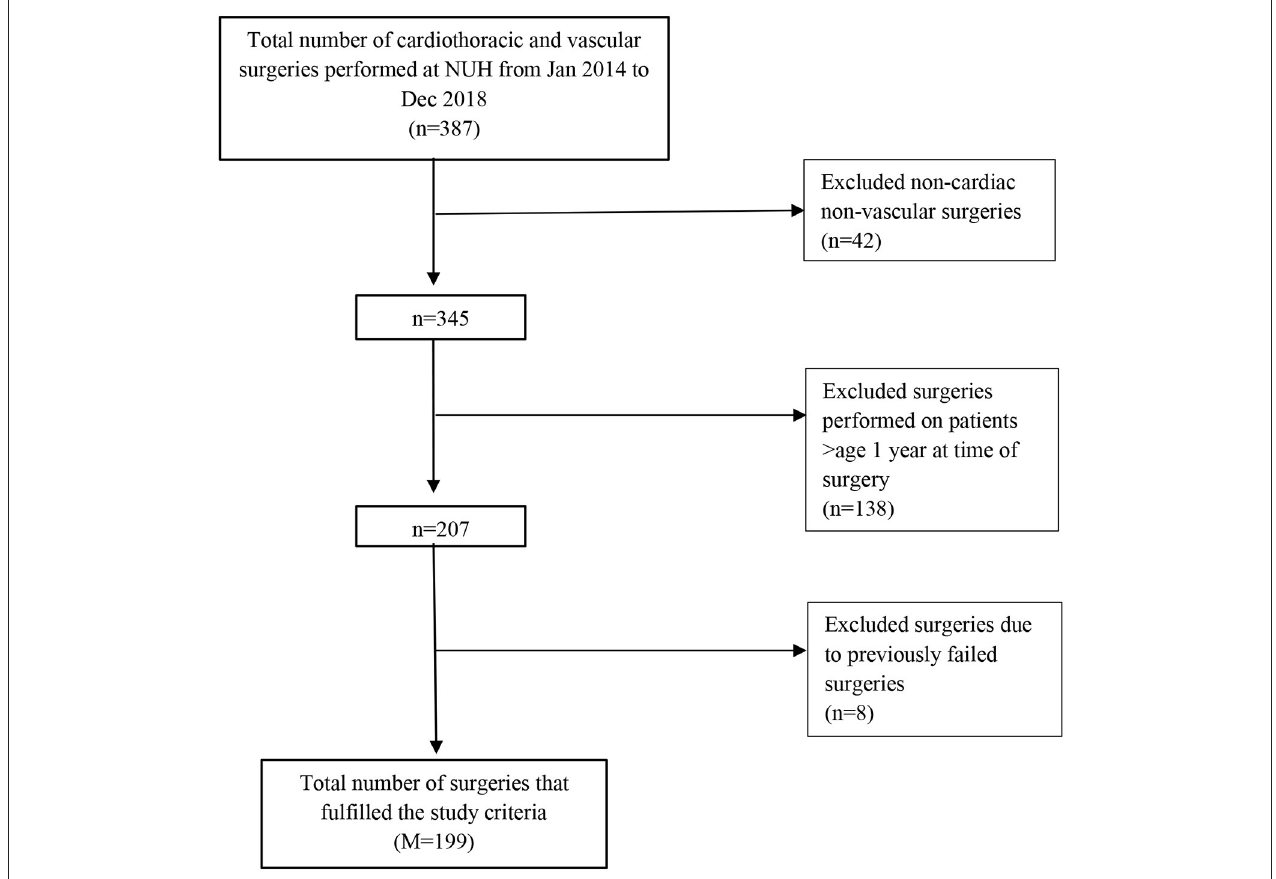
FIGURE 1 | Study inclusion